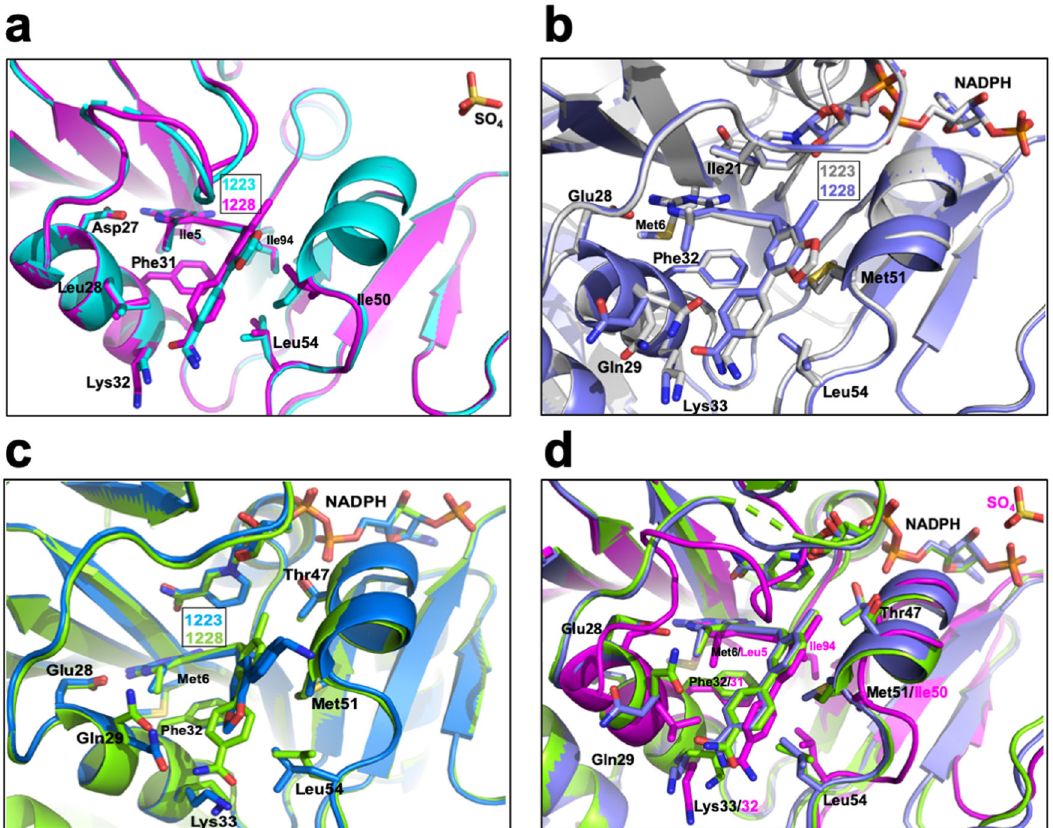
Fig. 4 Superimposed crystal structures of DHFR with UCP1223 and UCP1228. a Superposition of crystals structures of EcDHFR in complex with UCP1223 (cyan) and UCP1228 (magenta). b Superposition of crystals structures of DfrA1 in complex with UCP1223 (gray) and UCP1228 (purple). c Superposition of crystals structures of DfrA5 in complex with UCP1223 (blue) and UCP1228 (green). d Superposition of EcDHFR (magenta), DfrA1 (purple), and DfrA5 (green) in complex with UCP1228. Residues important to ligand binding are shown in stick mode and colored by